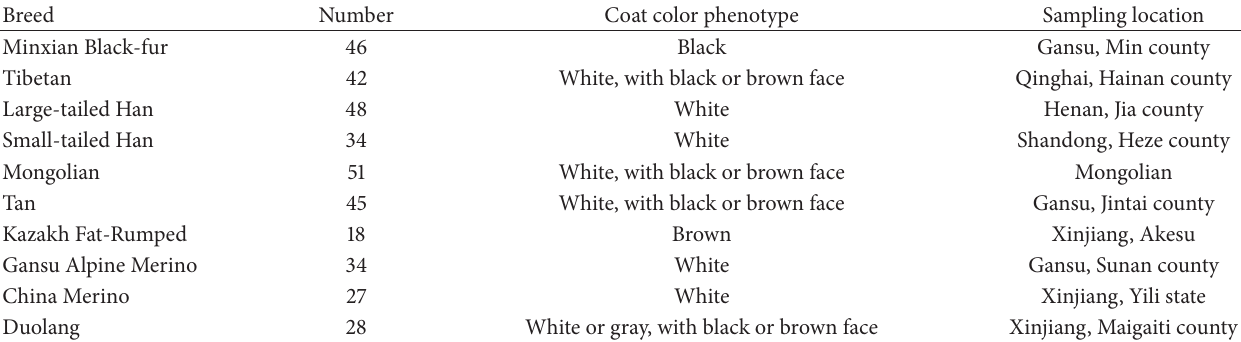
White or gray, with black or brown